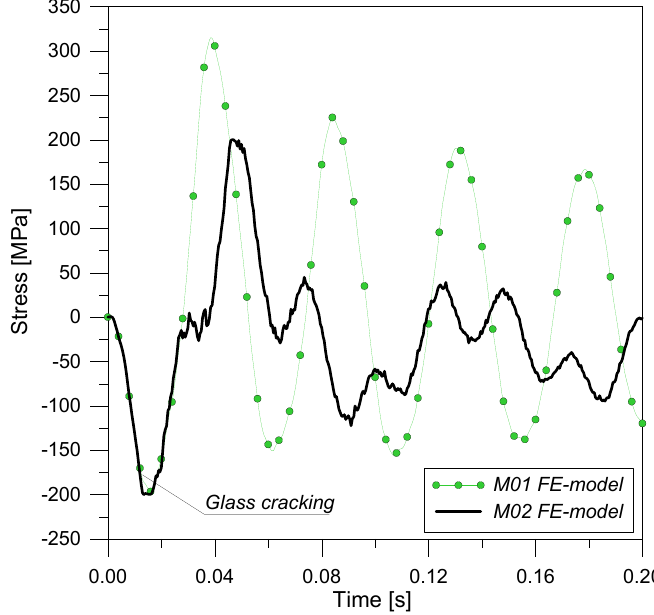
Figure 15. Comparison of maximum axial stress in vertical